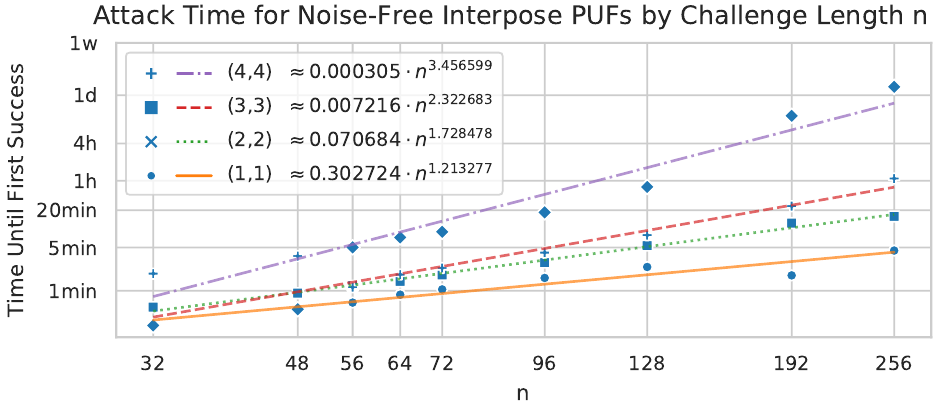
Figure 3: Attack run time for different challenge lengths; times shown refer to time until first success in single-threaded runs. Every data point shows the best obtained time until first success for various choices of guessed amounts of challenge-response pairs. Interpolations given were computed using regression for a, b on a · n b using all available data.